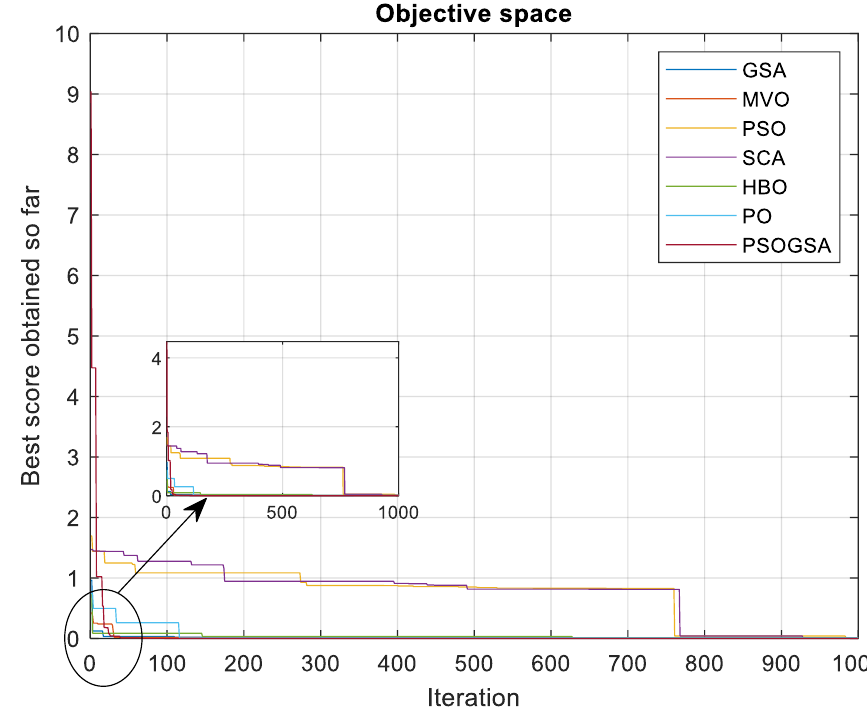
Figure 9. The convergence curve of the monocrystalline MDDM.